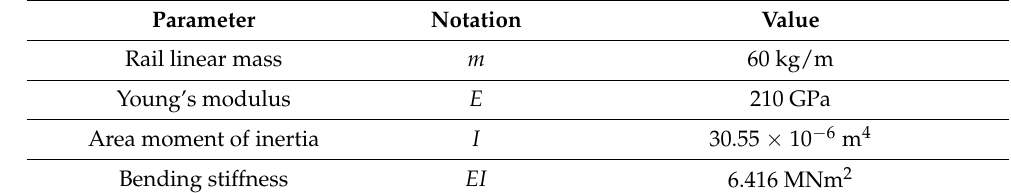
Table 3. Wheel–rail model parameters.